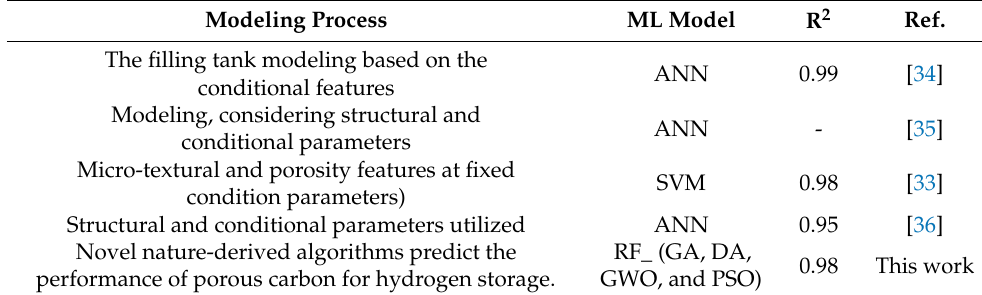
Table 1. The previous works of literature on hydrogen storage via machine learning. Modeling